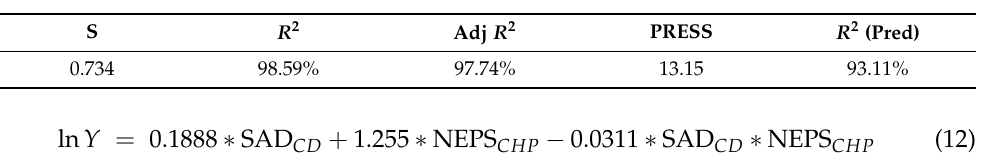
Table 11. Predictive ability and fit of Cook dinner PLSR